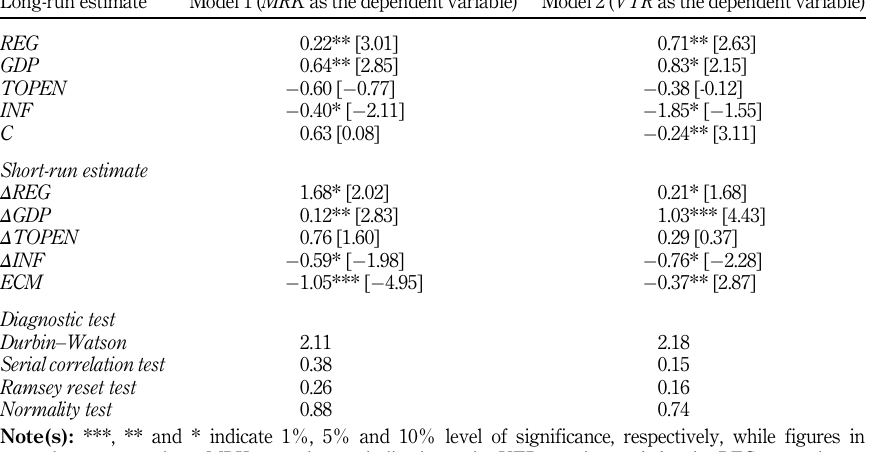
Table 8. ARDL long-run and short-run